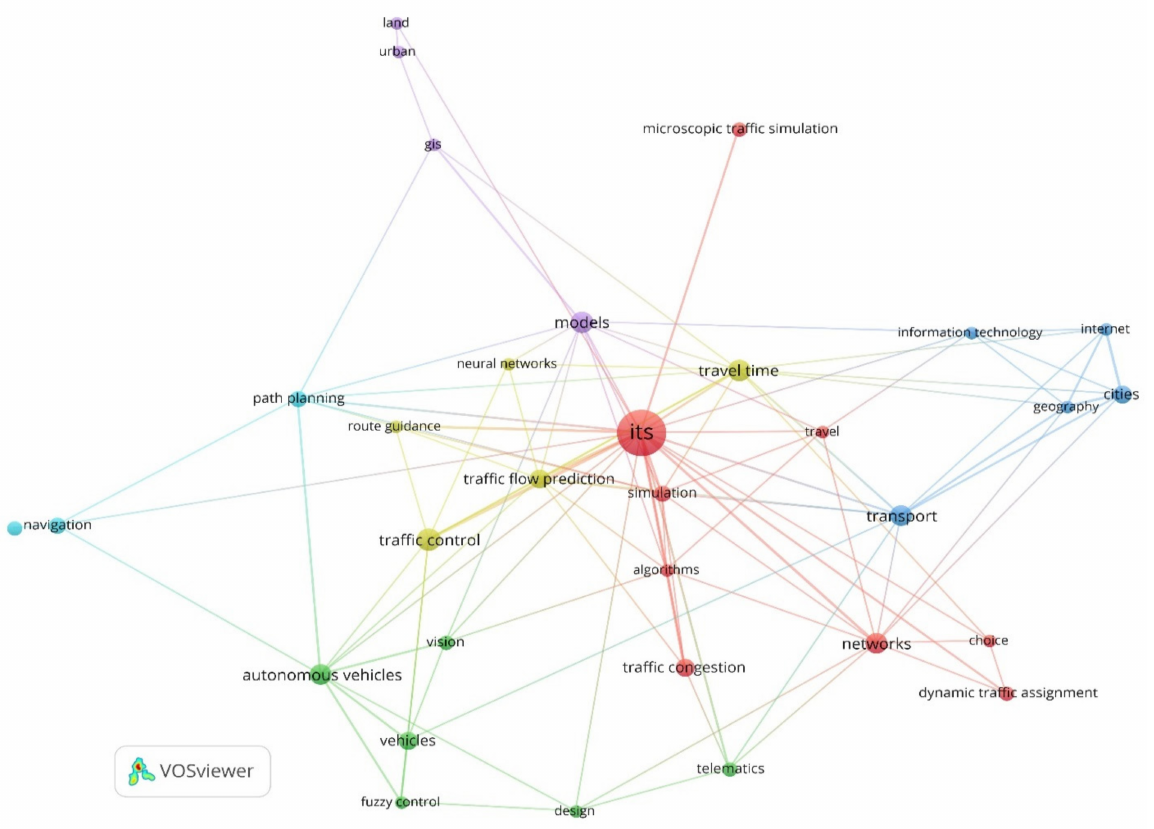
Figure 8. Mapping keywords output from 1968 to 2010. Illustration by